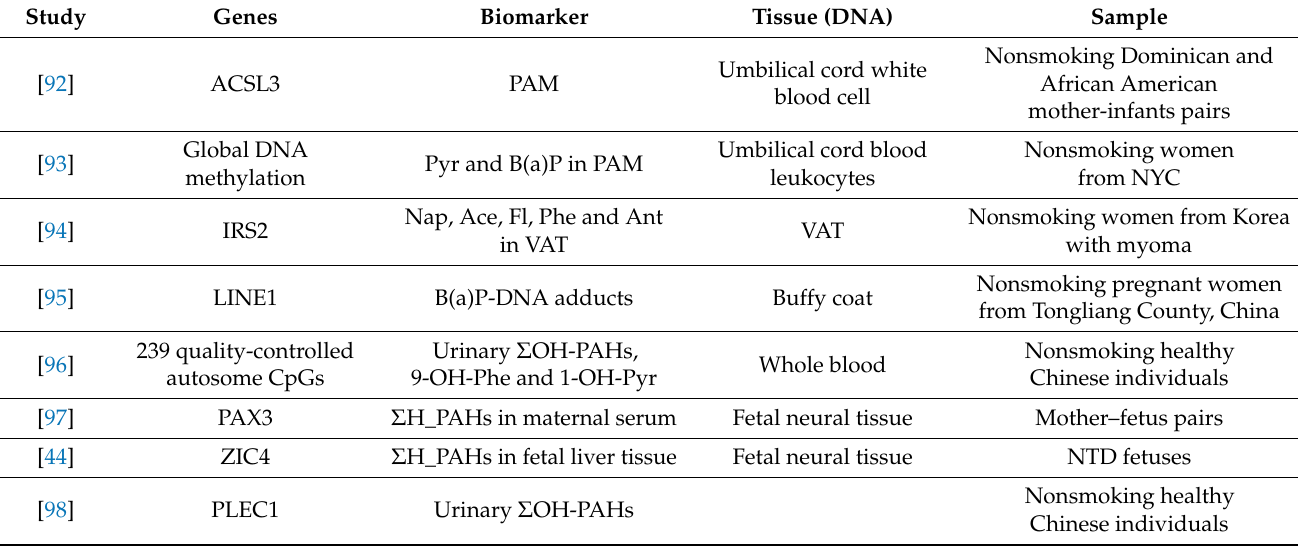
Table 4. List of epidemiological studies investigating the impact of PAHs exposure on DNA methylation. Genes in which the differentially methylated CpG dinucleotides were identified, biomarkers measured, tissues from which DNA was extracted, and samples studied are shown for each